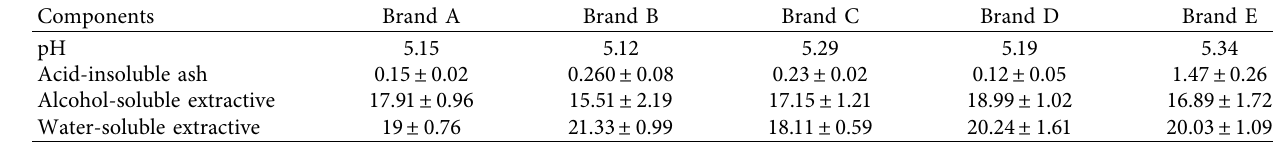
Table 2: Physicochemical evaluation of Chyawanprash (average ± standard deviation).